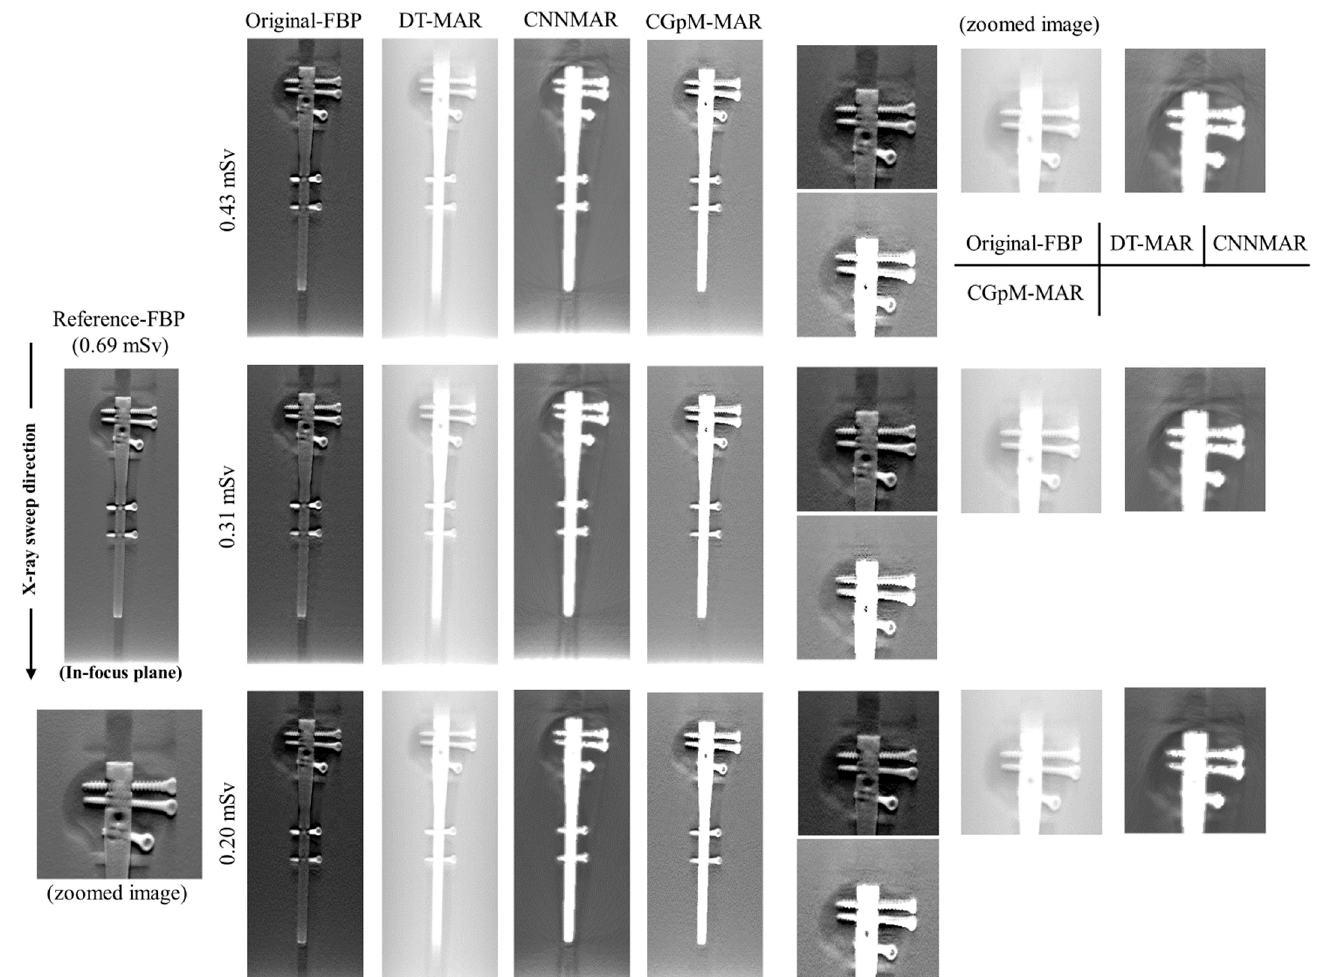
Figure 4. Comparisons between the combined hybrid GAN, cycle-GAN_pix2pix_MPN algorithm[CGpM-MAR, and the conventional reconstruction algorithms with and without metal artifact reduction (MAR; reference FBP [showing window: 0.15–0.44], 0.43 mSv; CGpM-MAR [0.27–0.34], original FBP [0.15–0.44], DT-MAR [0–0.72], CNNMAR [0–0.20], 0.31 mSv; CGpM-MAR [0.24–0.32], original FBP [0.15–0.44], DT-MAR [0–0.72], CNNMAR [0–0.20], 0.20 mSv; CGpM-MAR [0.05–0.22], original FBP [0.15–0.44], DT-MAR [0–0.72], CNNMAR [0–0.20]) in the in-focus plane. Metallic implants were replaced with constant values (white) after processing with CGpM-MAR and CNNMAR. The display variety of the prosthesis phantom was changed for visual comparison of the contrast and background gray levels. The X-ray source was moved along the image vertically. In the displayed areas, the artifact indexes were determined.